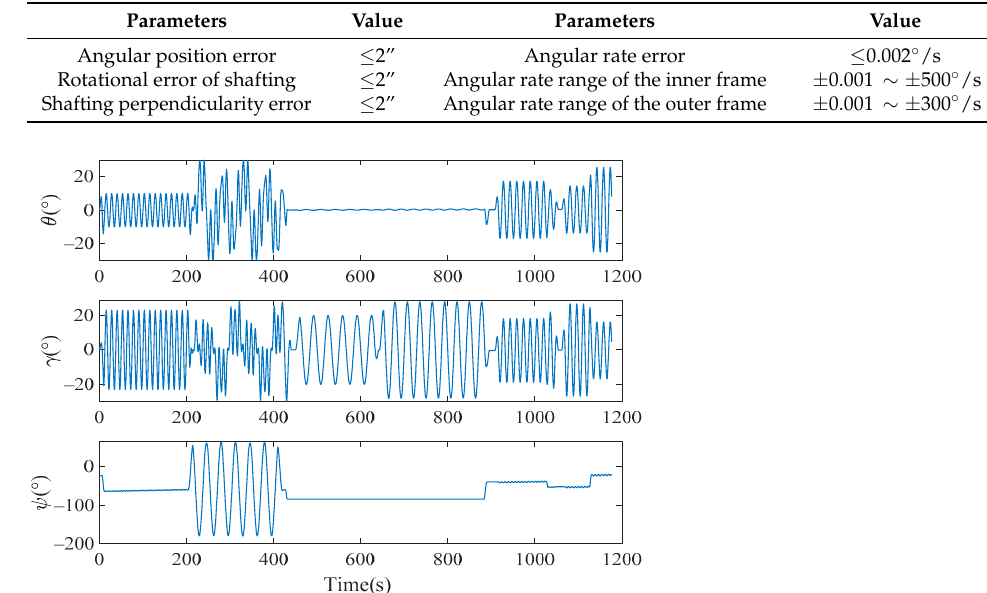
Table 5. Parameters of the two-axis turntable.